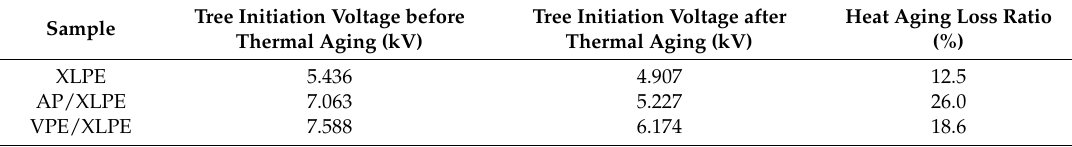
Table 4. Electrical tree initiation voltage of different samples of Thermal aging before and after.